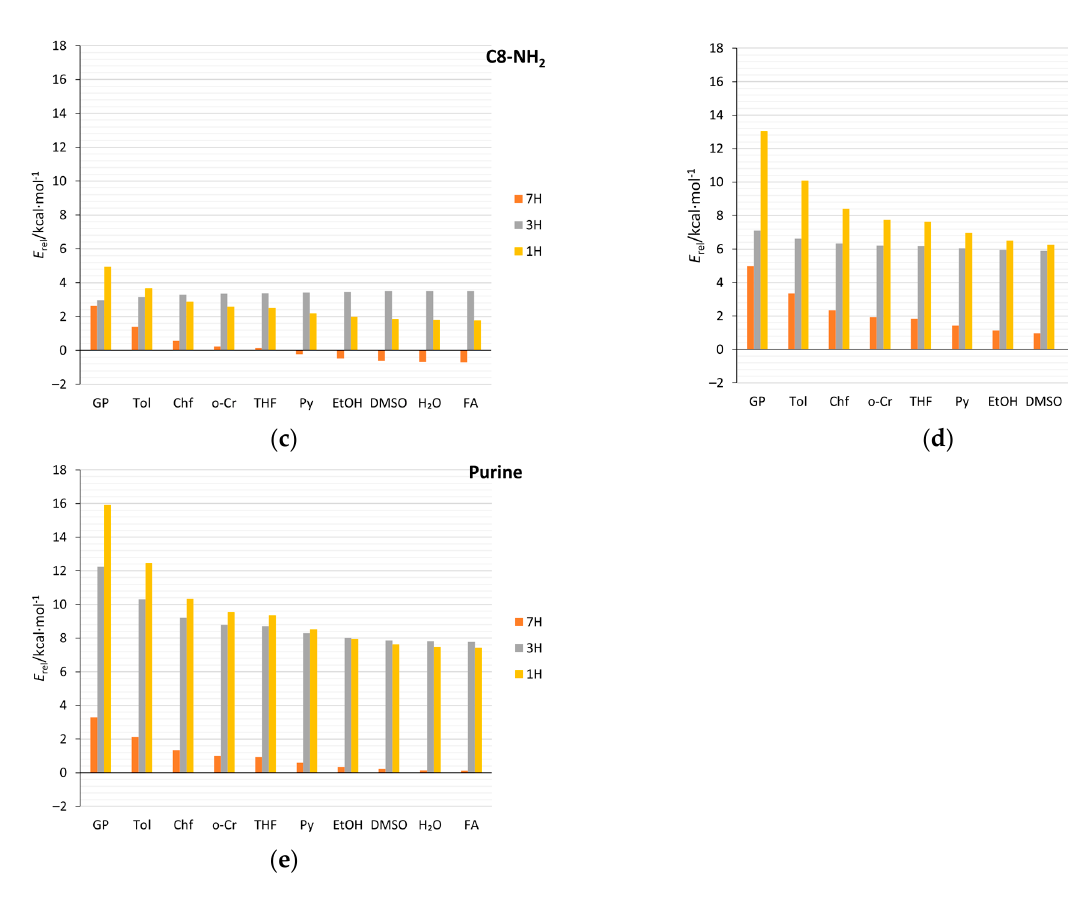
Figure 10. Relative energies of tautomers ( E rel ) in various solvents (abbreviations and dielectric constants in Table 1), with respect to the 9H tautomer, for ( a ) C2-NH 2 , ( b ) C6-NH 2 ( c ) C8-NH 2 ( d ) N-NH 2 , and ( e ) unsubstituted purines.